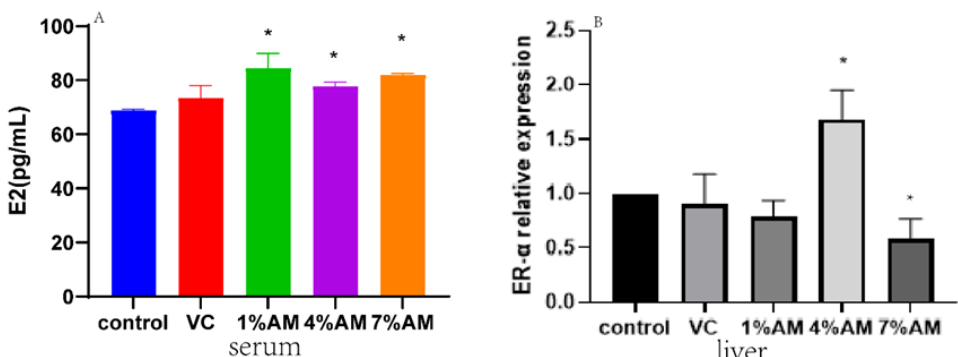
Figure 4. Effects of feed supplemented with AM on E2 and ER- α . E2 content ( A ) in serum, ER- α ( B ) gene expression in liver. Values are shown as mean ± SD ( n = 6). Significant differences compared to control group are designated as * show significant difference at p < 0.05. Abbreviations: E2, Estrogen, ER- α , Estrogen receptor- α